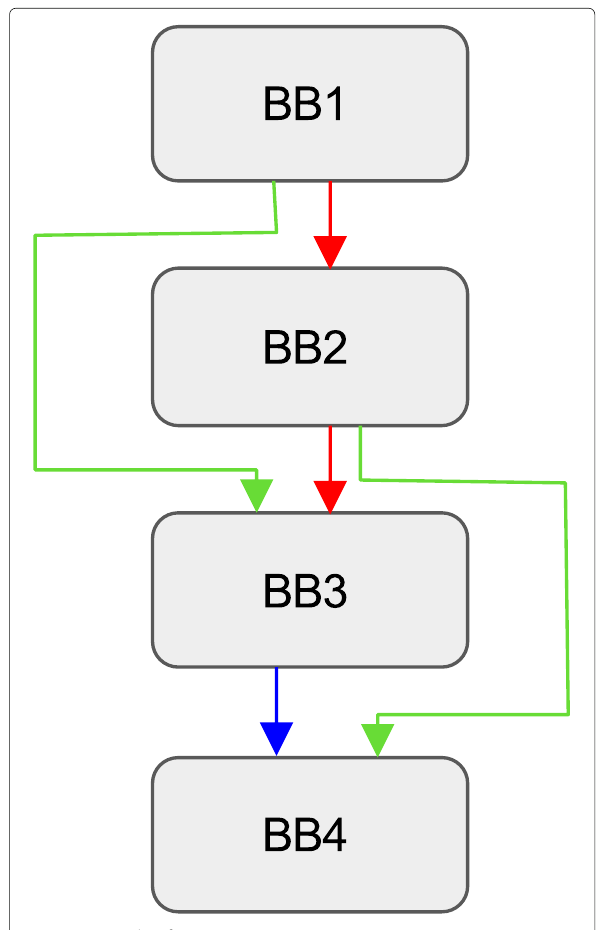
Fig. 2 A sample of BB